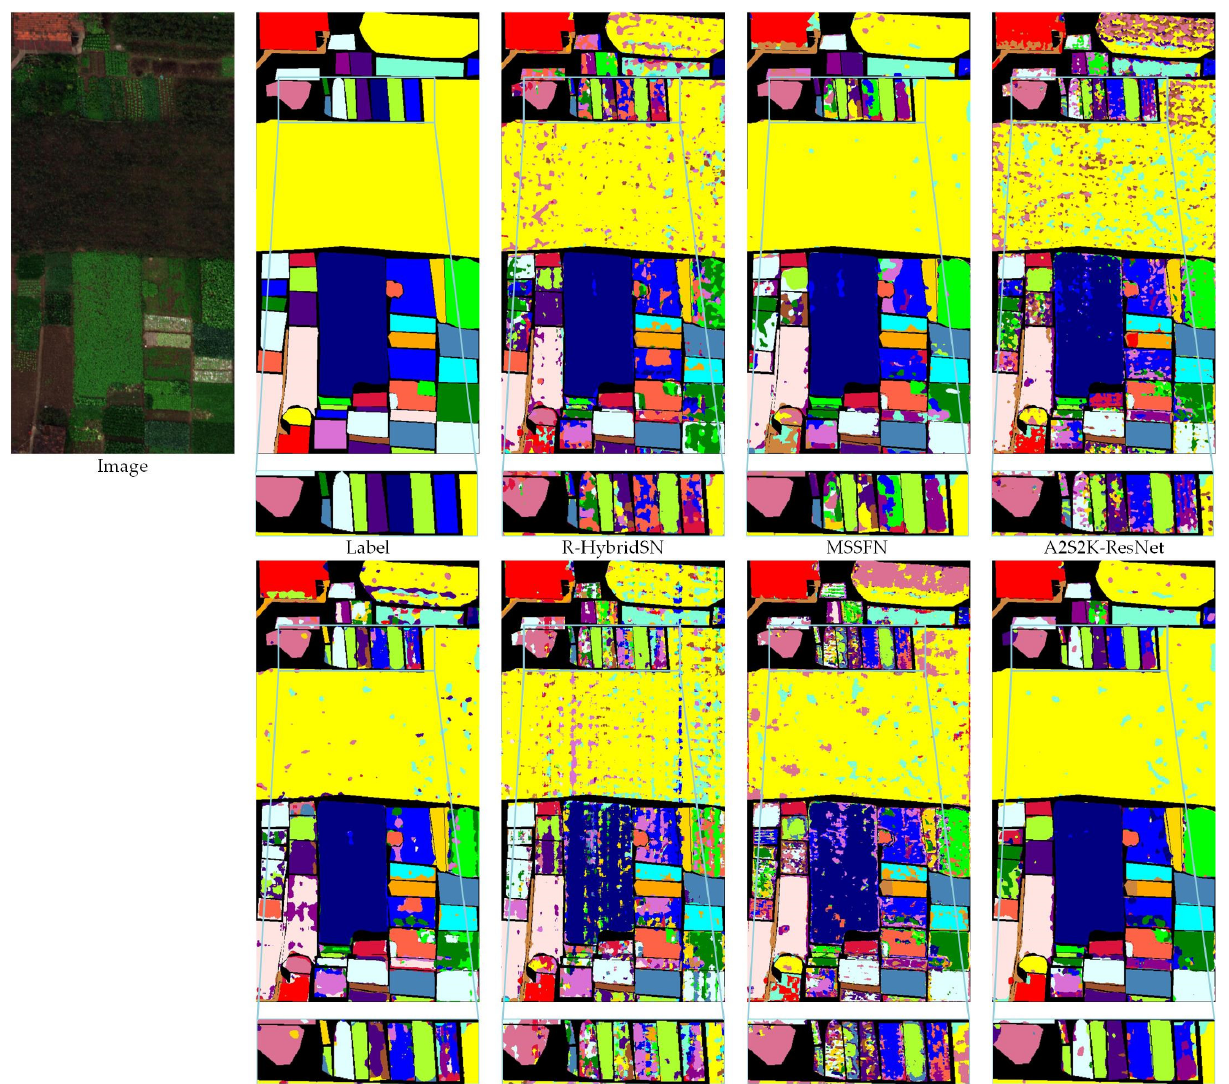
Figure 8. Classification maps of all models for WHU dataset.